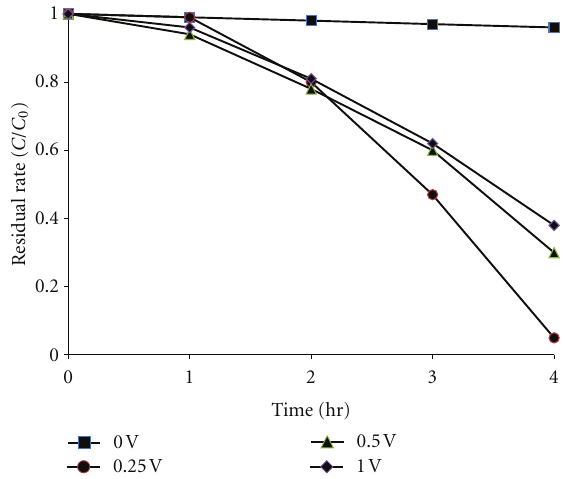
Figure 7: Residual rates of sodium oxalate under photoelectrocat- alytic reactions with di ff erent additional applied electric potentials. reason for the higher adsorption at lower pH was that